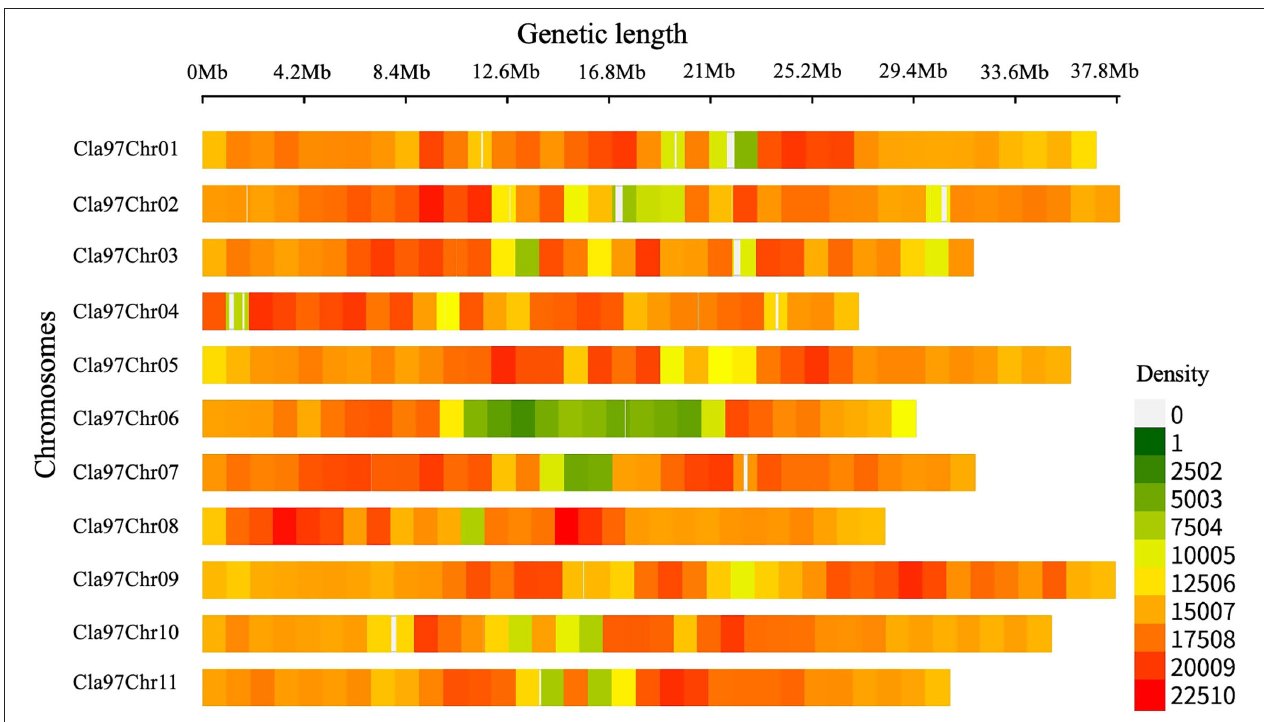
FIGURE 2 | Total SNP variants detected within a 1-Mb window-sized chromosomal region of re-sequenced parent lines of watermelon.